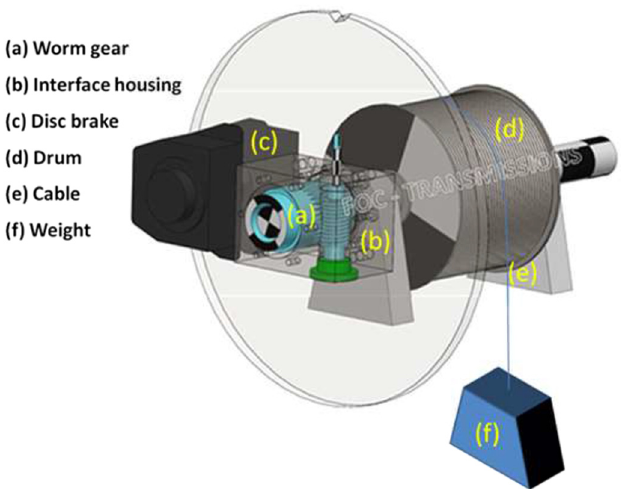
Fig. 1. Schematic representation of lifting device equipped with Fastbrake © system. (Courtesy of FOC